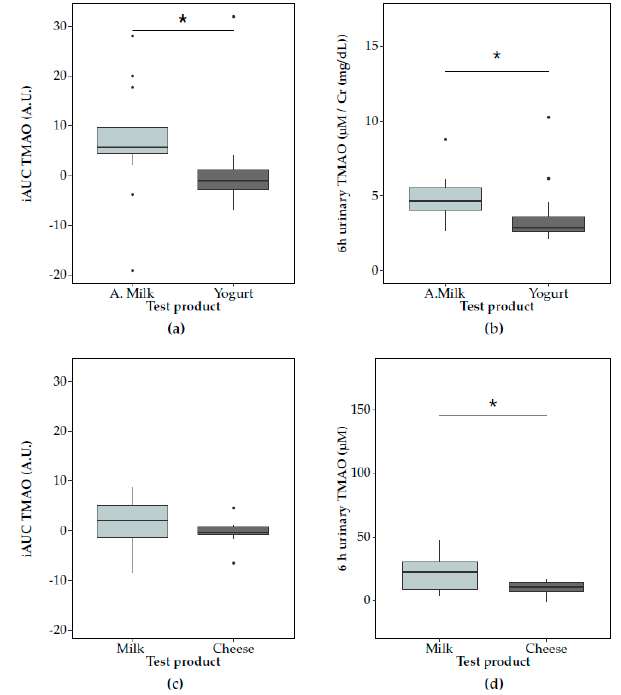
Figure 2. Postprandial trimethylamine- N -oxide (TMAO) responses in plasma (summarised by net incremental area under the curve (iAUC)) and urine after consumption of non-fermented milk (light grey) and a fermented milk product (dark grey) consumption. In Study 1, TMAO responses to acidified milk (‘A.milk’) and yogurt are compared in ( a ) plasma and ( b ) urine. In Study 2, TMAO responses to milk and cheese are compared in ( c ) plasma and ( d ) urine. The concentrations of TMAO after the dairy products’ tests are compared using the paired Wilcoxon signed-rank test (significance at p < 0.05, indicated by *). Plots show the IQR (box), the median dividing the IQR ( ― ), with whiskers that extend to the last point included in the 1.5 × IQR range and outliers outside this range identified (•).